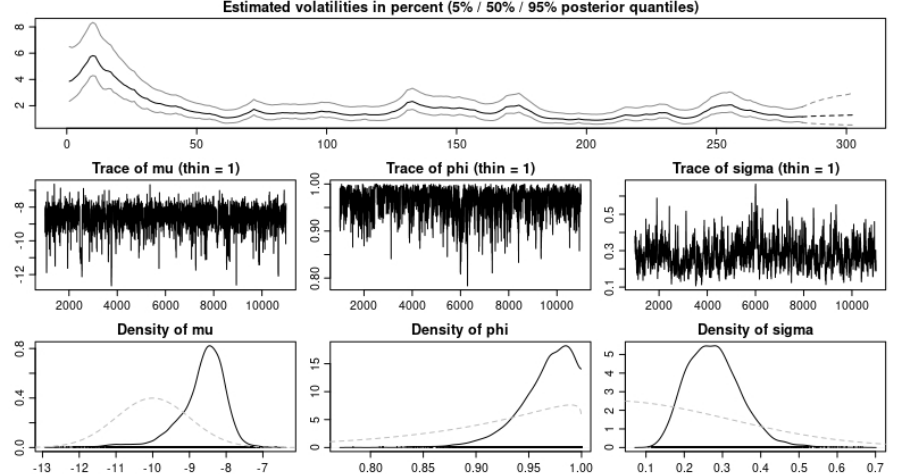
Figure 5. Graph showing estimated volatility for the